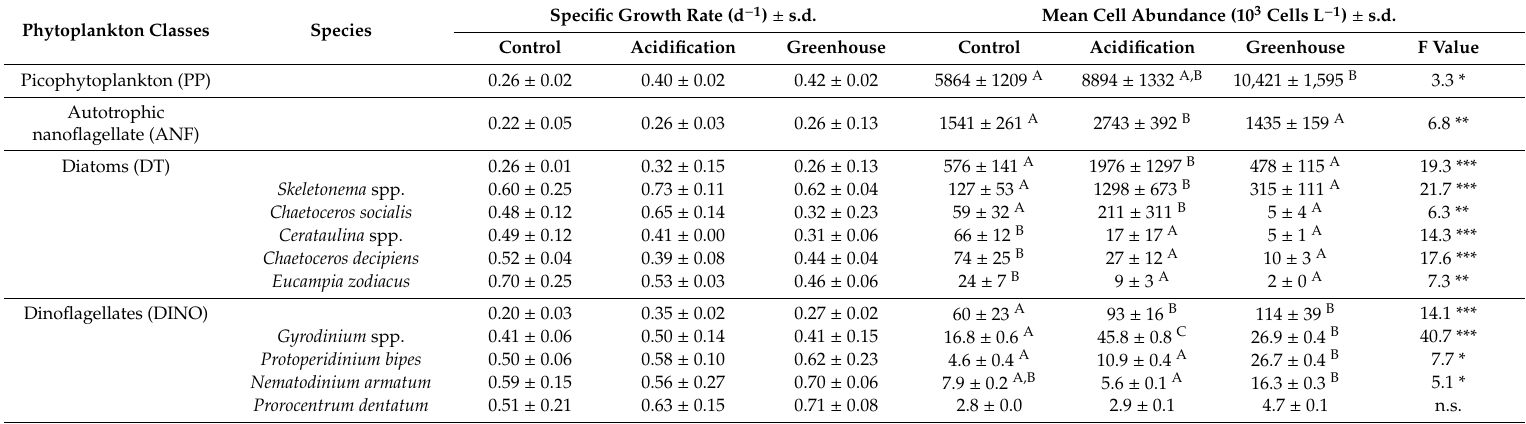
Table 1. E ff ects of pCO 2 and temperature manipulation on specific growth rates and the mean cell abundance of phytoplankton groups and dominant species in the control, acidification, and greenhouse enclosures. The mean cell abundance and its statistical results were calculated during the bloom period (for PP, ANF, and DT) and the post-bloom period (for